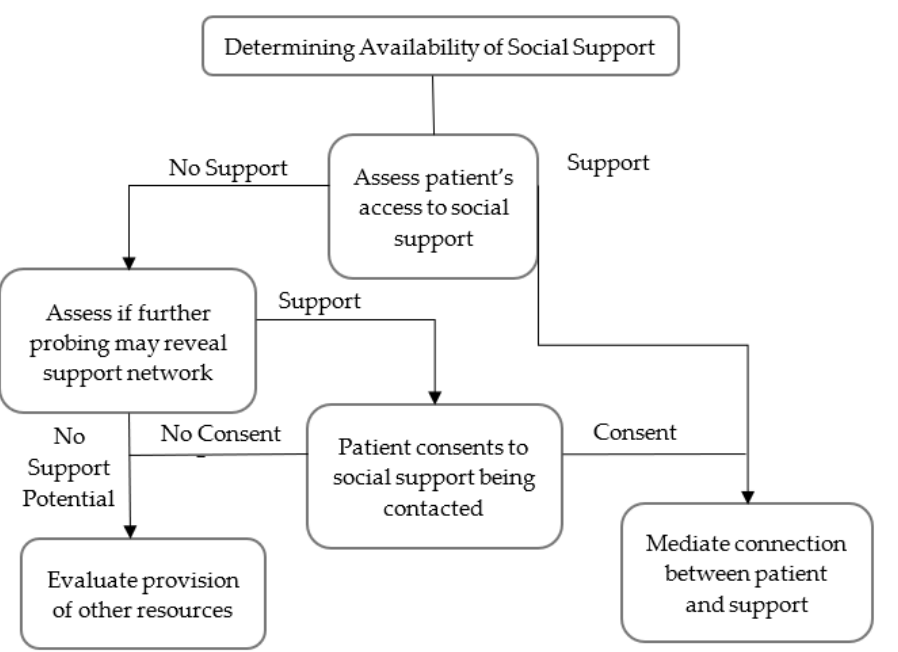
Figure 1. Framework flowchart for assessing patient support network.